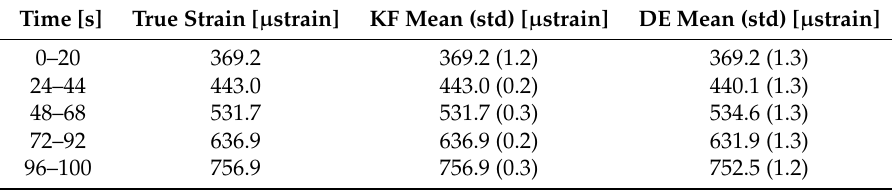
Table 1. Comparative performance of DE- and KF-based estimation for bending strains.